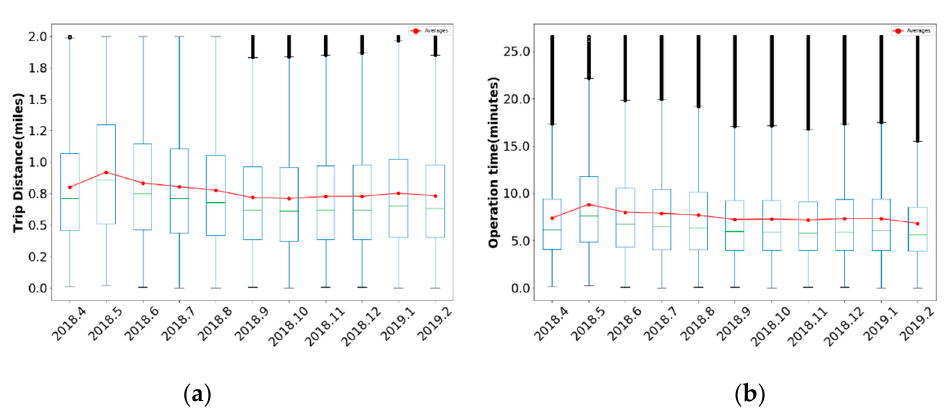
Figure 1. Boxplot analysis of monthly E-scooter trips in Austin TX. ( a ) Average E-scooter trip distance in different months; ( b ) Average E-scooter operation time in different months.